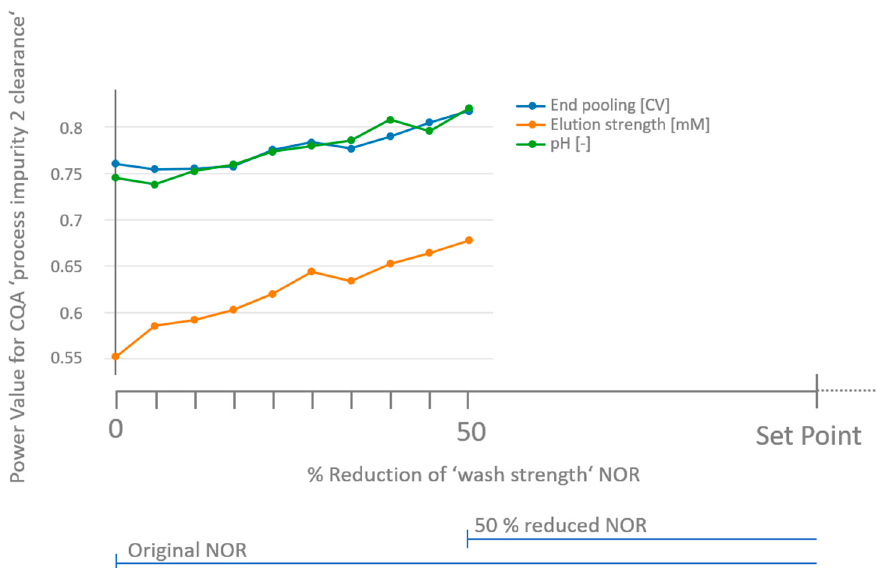
Figure 3. Retrospective power values for ‘process impurity 2 clearance’ for unit operation CC 1 as a function of tightened NOR of process parameter ‘wash strength’. Since wash strength and column loading density are significant parameters in this model, the power was not assessed for those two parameters. Upon reducing the NOR symmetrically by 50% of the significant parameter ‘wash strength’, power values of all other parameters increase since the critical gap is increased, too, due to a reduction of the worst case model prediction in the NOR (Equation (18)).